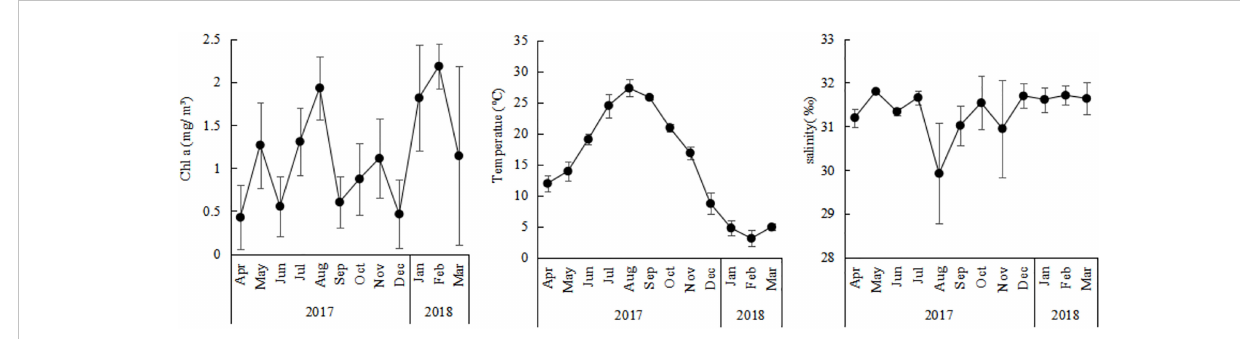
FIGURE 2 Annual variations of CHL a concerntration, temperature, and salinity in Jiaozhou Bay, vertical bars represent standard deviation